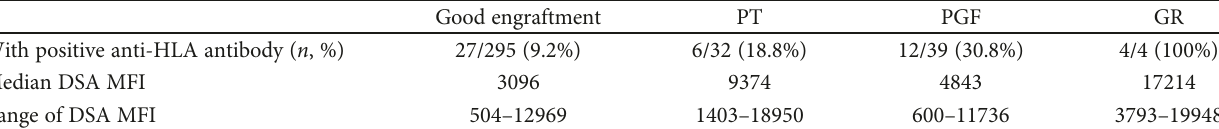
Table 2: The HLA-antibodies and DSA in di ff erent statuses of engraftment. Good